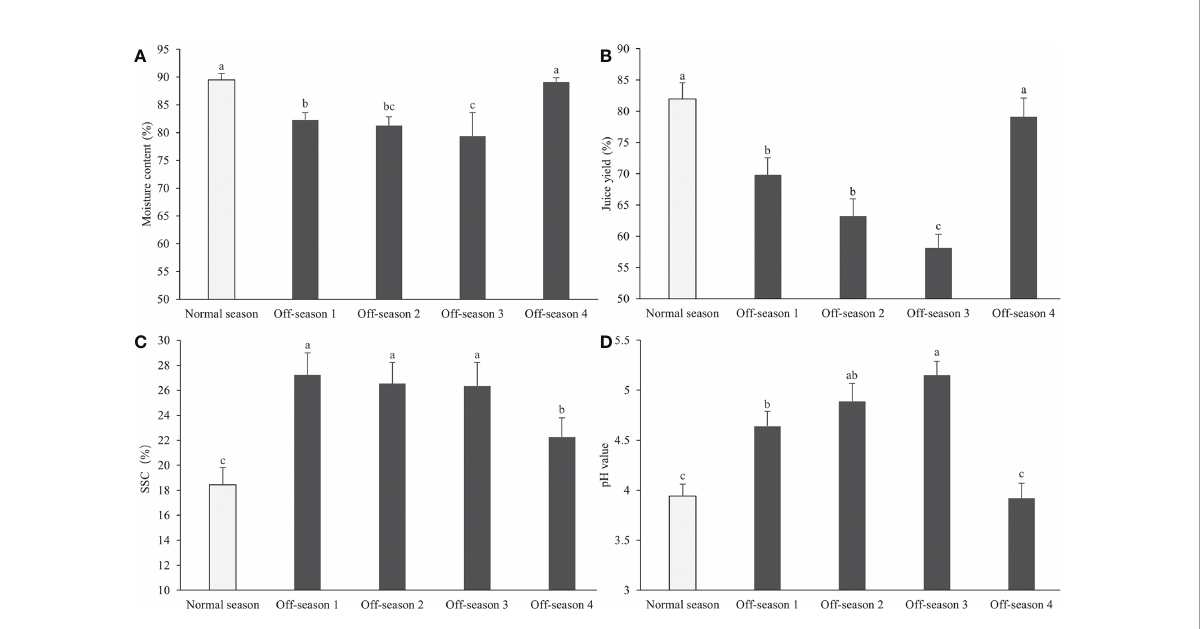
FIGURE 4 Moisture content, juice yield, pH value and SSC content of differential groups ’ mulberry fruits. (A) Moisture content, (B) juice yield, (C) SSC, (D) pH value. Within a panel, bars labeled with different lowercase letters differ signi fi cantly ( P< 0.05).